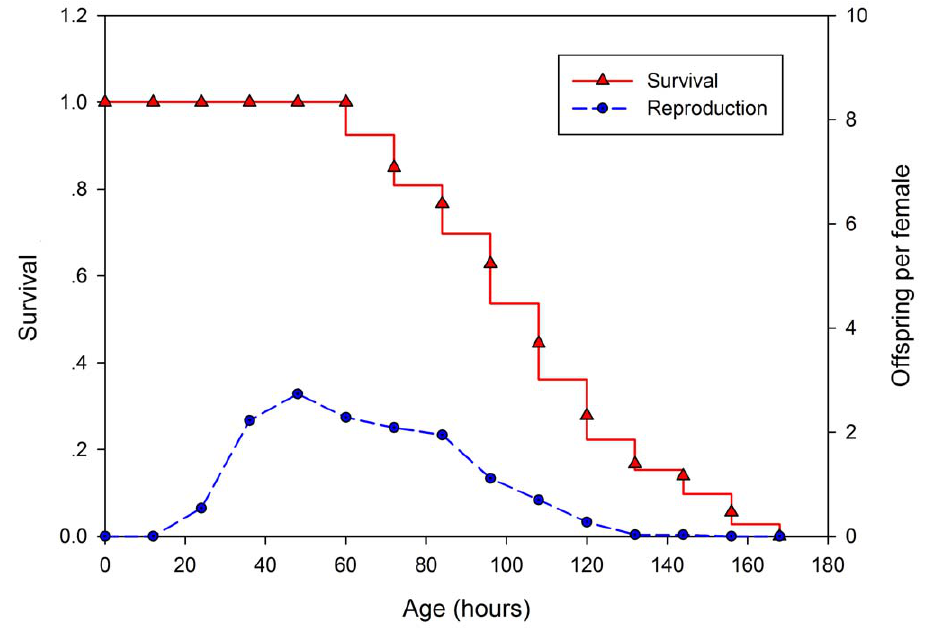
Figure 1. Typical survival and fecundity curves for B.calyciflorus under control conditions.